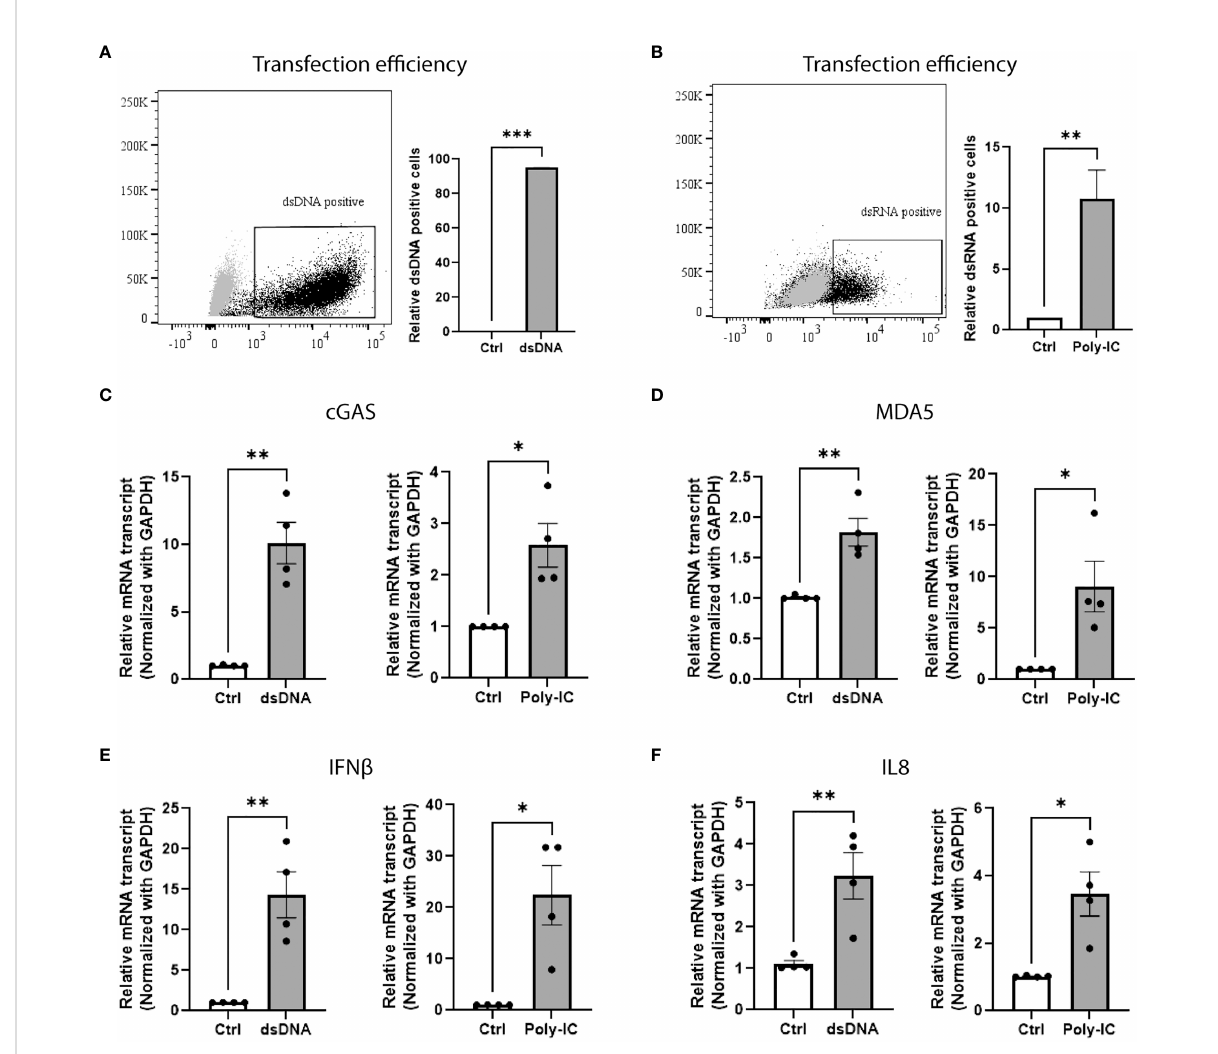
FIGURE 1 Beta-cell senses exogenous nucleic acids and activates type-I interferon innate immune response. Transfection ef fi ciency of (A) FAM-labeled dsDNA and (B) Poly-IC in EndoC- b H1 cells. The results are represented by dot plot (left panel) of FACS image and mean ± SEM (right panel) of relative dsDNA and dsRNA positive cells. qPCR analysis of EndoC- b H1 transfected cells showing the relative mRNA expression of cytosolic sensor for (C) dsDNA cGAS, (D) dsRNA MDA5, (E) type 1 interferon gene IFN b and (F) chemokine IL8. Data are presented as mean ± SEM (n = 4) and statistically analyzed by student ’ s t-test. Signi fi cance is indicated by *P < 0.05, **P < 0.01, and ***P <